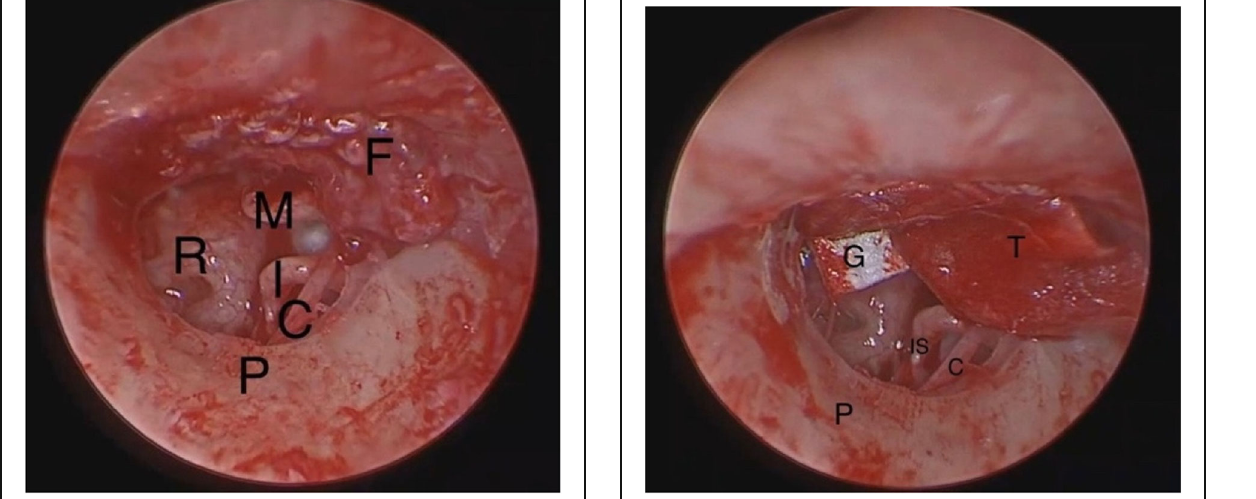
Fig. 4 Packing the middle ear cavity with gelfoam. P, posterior meatal wall; C, chorda tympani; IS, incudo-stapedial joint; M, malleus; T, Tutoplast; G,